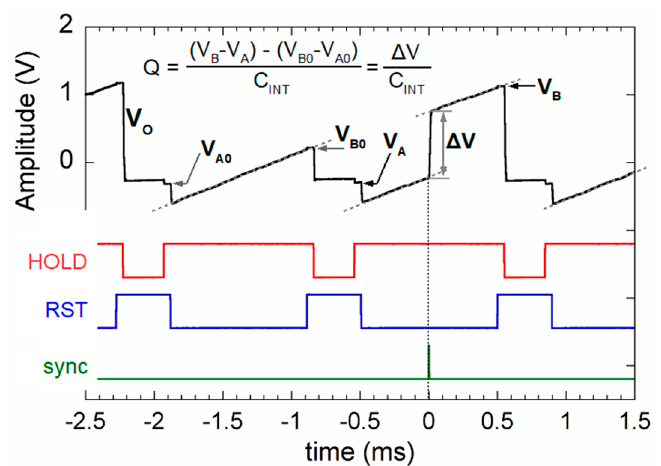
Figure 8. Time diagram related to GI output V O for a 10 nA DC current superimposed to a 1 µA pp , 10 µs wide, AC pulse. Δ V voltage step, related to the injected charge, can be correctly acquired by means of the implemented differential measurement method according to the reported equation.